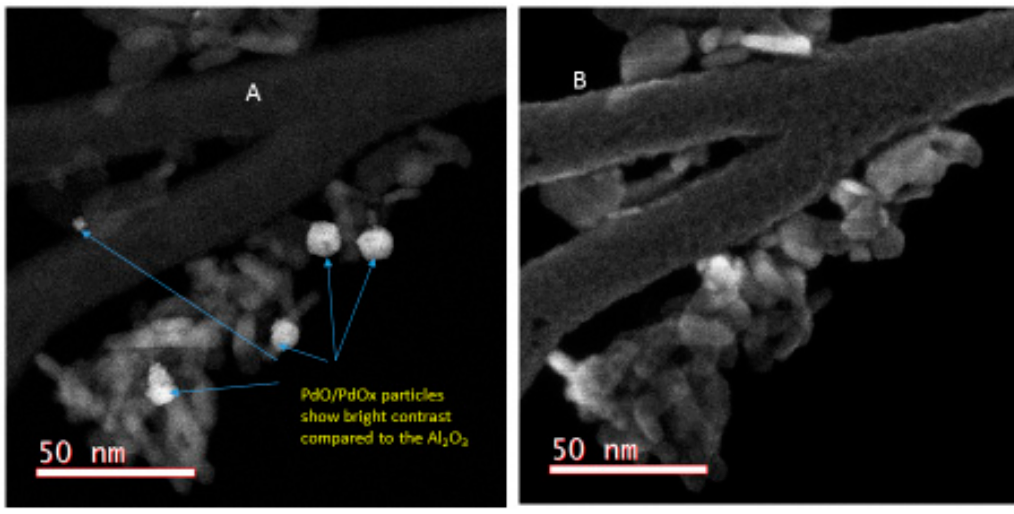
Figure 3. ( A ) HAADF STEM image from the same area of EDS mapping; ( B ) SEM image from the same area of EDS mapping.